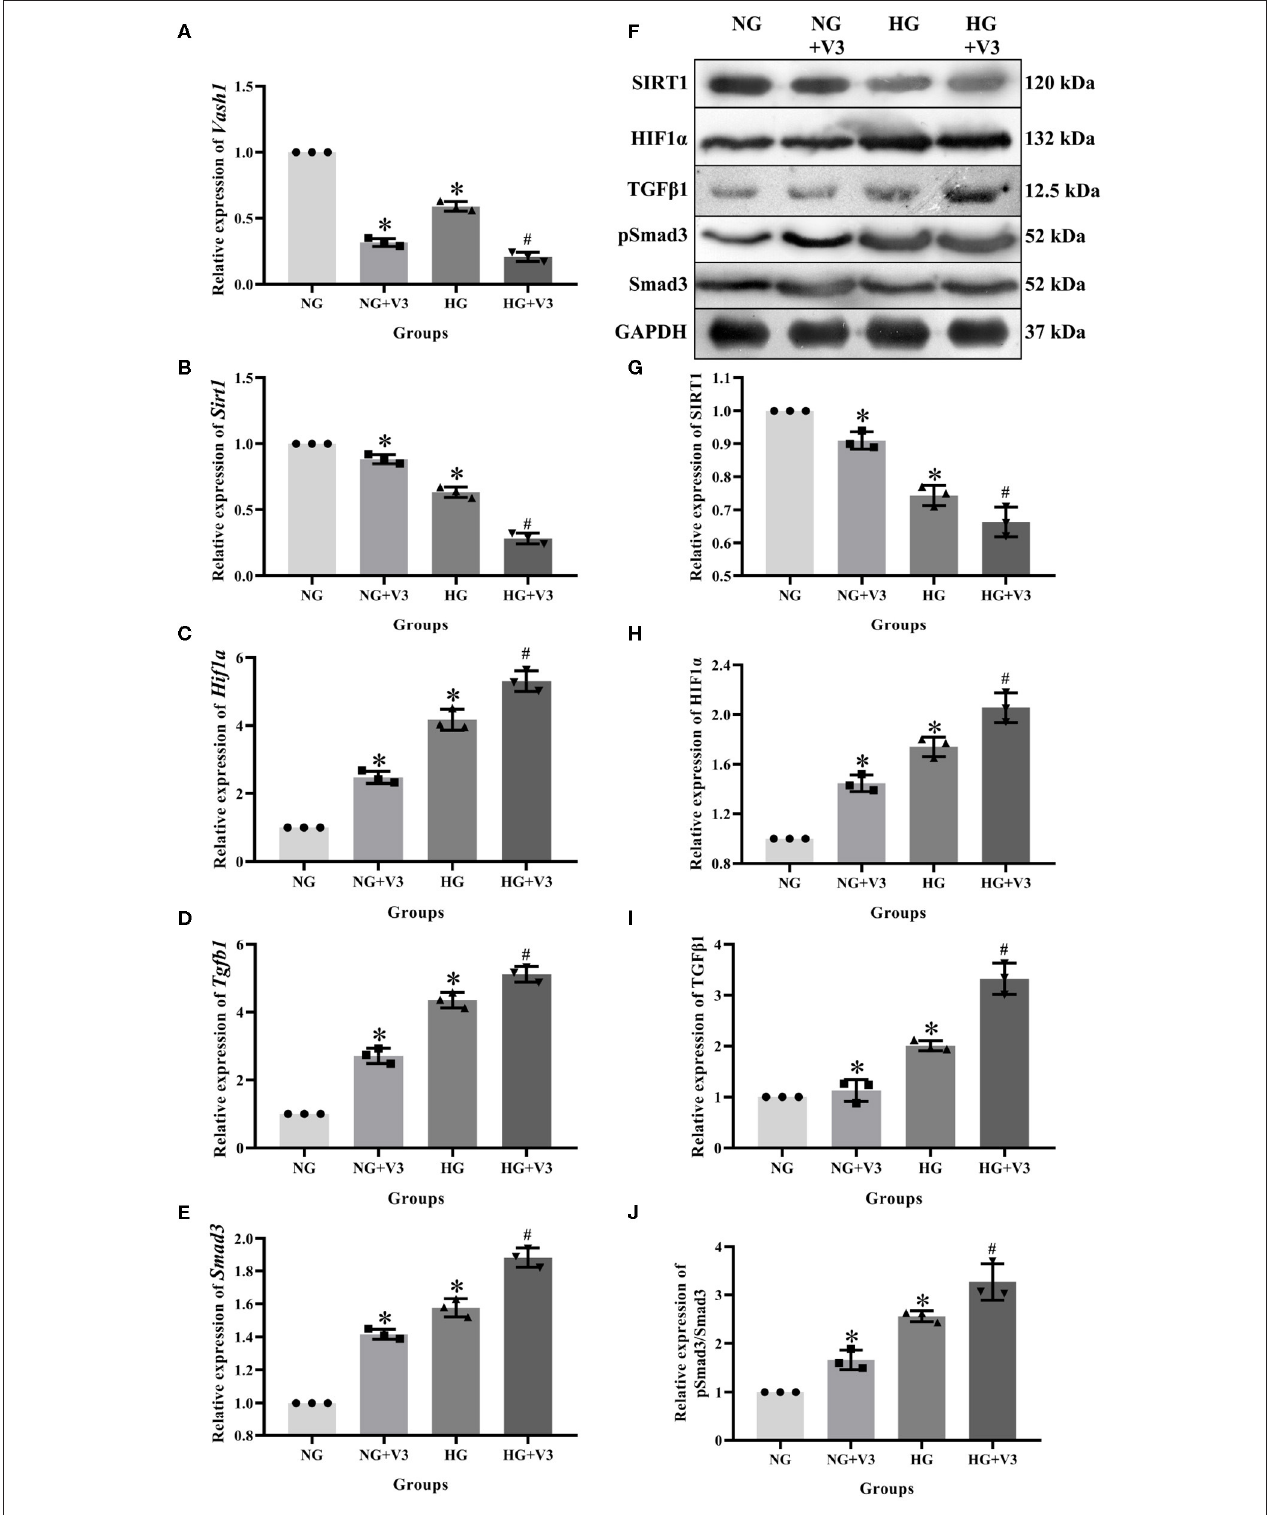
FIGURE 7 | Effects on pathway of Vash1 siRNA transfection in high glucose cultured RMCs. Relative expression levels of (A) Vash1 , (B) Sirt1 , (C) Hif1a , (D) Tgfb1 , and (E) Smad3 mRNA, (F) Western blot protein bands, relative expression levels of (G) SIRT1, (H) HIF1 α , (I) TGF β 1, (J) pSmad3/Smad3. *Compared with the NG group, P < 0.05; # Compared with the HG group, P < 0.05. Data were expressed as mean ± SD, and results were repeated three